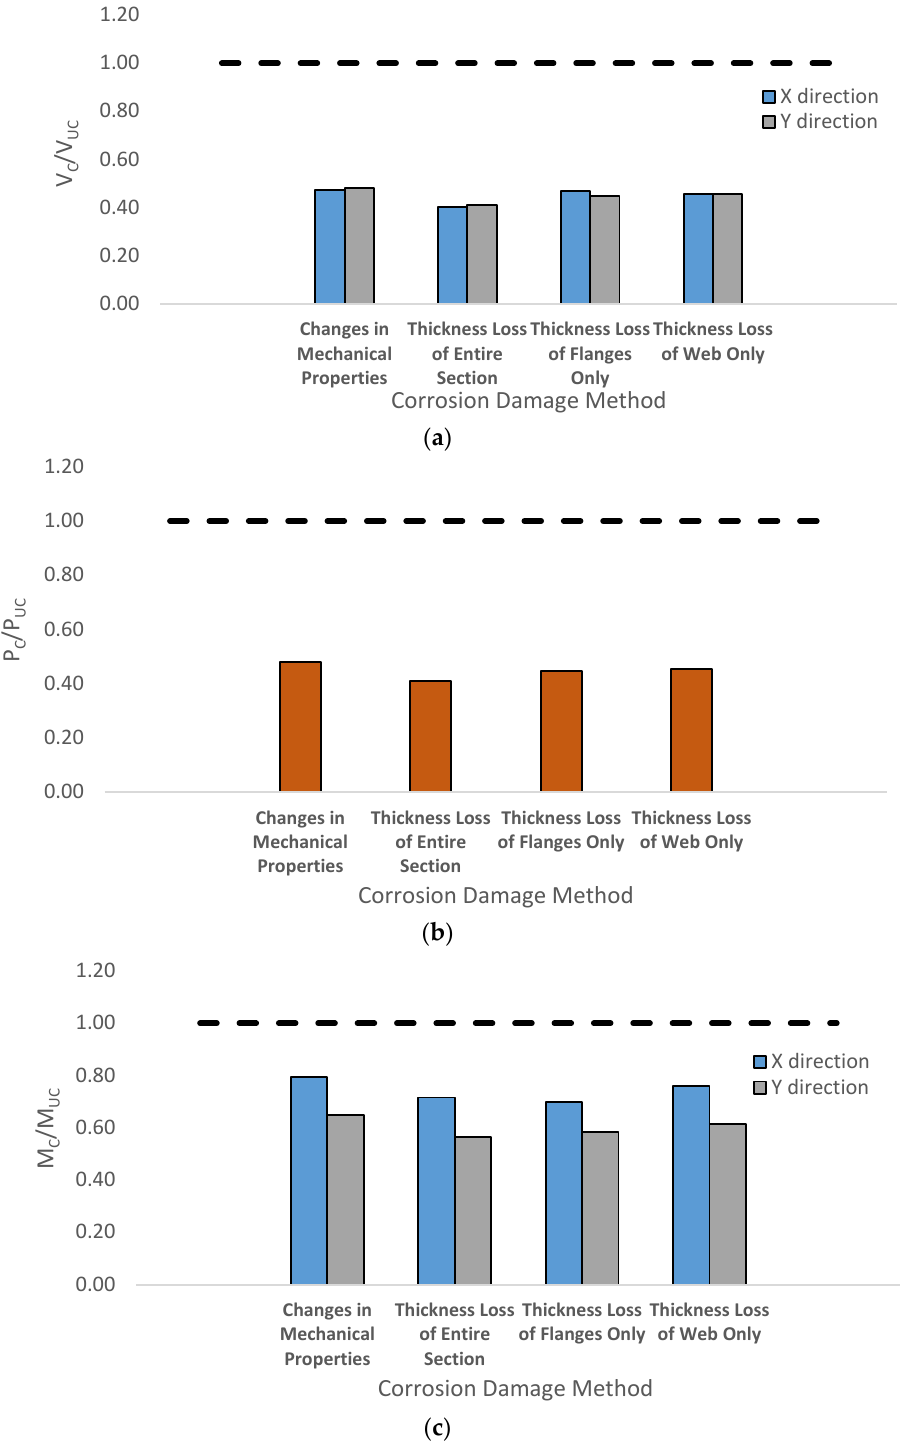
Figure 13. Variation of reaction force by different damage methods for: ( a ) shear; ( b ) axial and ( c ) moment force. (V C , P C , and M C are for corroded structure and V UC , P UC and M UC are related to uncorroded case).